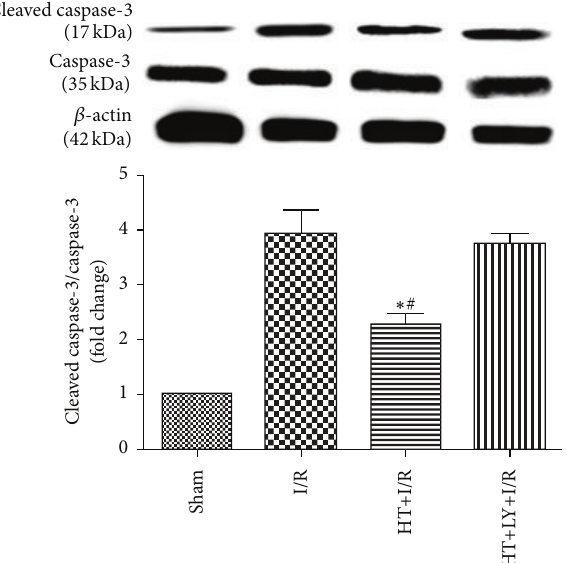
Figure 5: HT decreased cleaved caspase-3 expression as com- pared with expression levels in the I/R group and the HT+LY+I/R group ( 𝑛 = 4 for each group). Data are presented as means and SEM. ∗ 𝑃 < 0.05 versus I/R group. # 𝑃 < 0.05 versus HT+LY+I/R